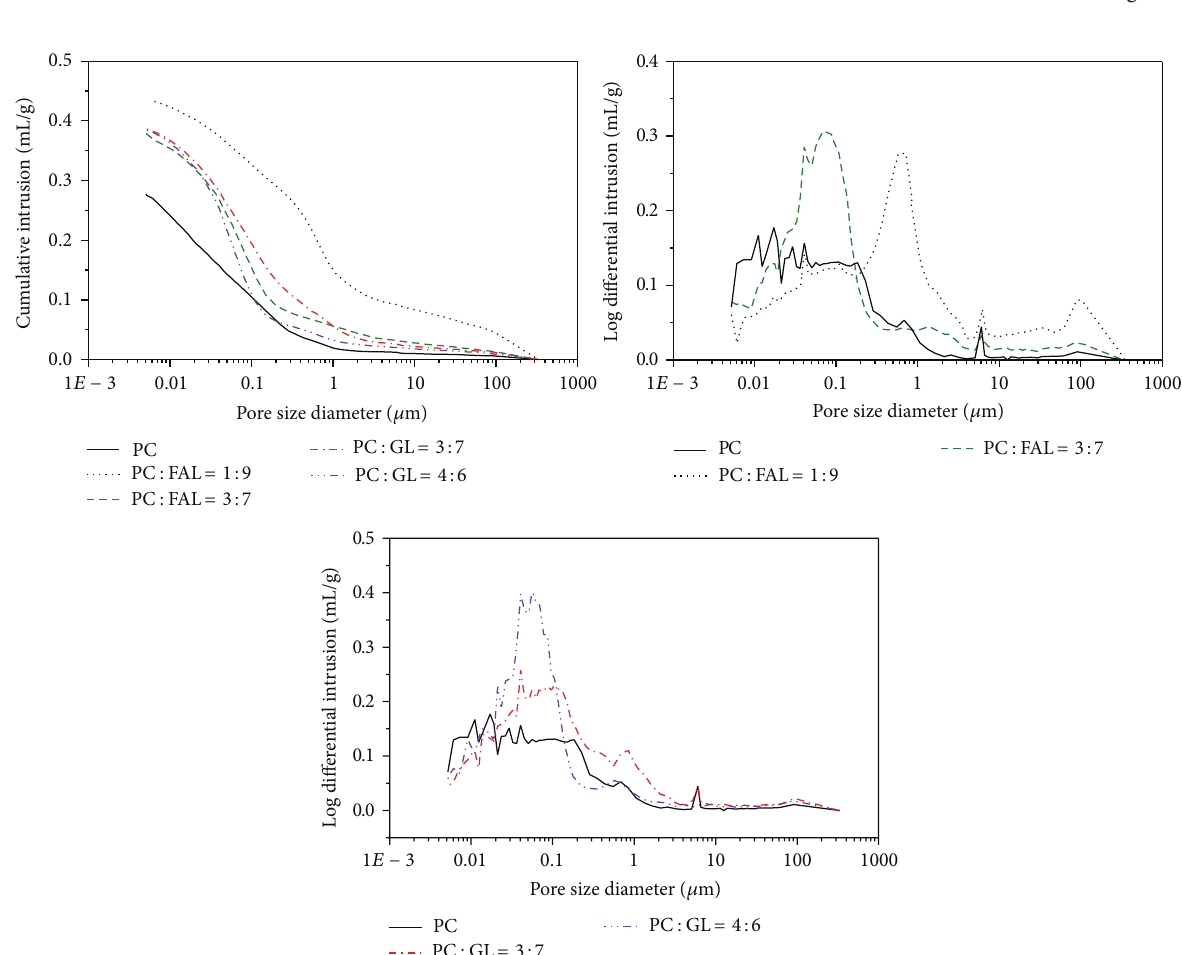
Figure 6: Cumulative mercury intrusion and log differential intrusion versus pore size diameter curve after 28 days of curing.